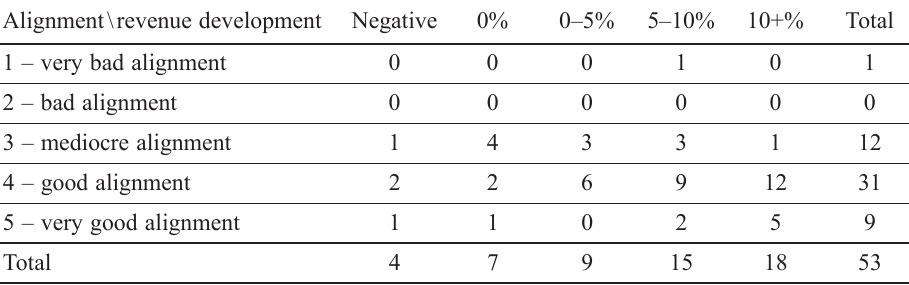
Table 1. Revenue development and alignment of business and information